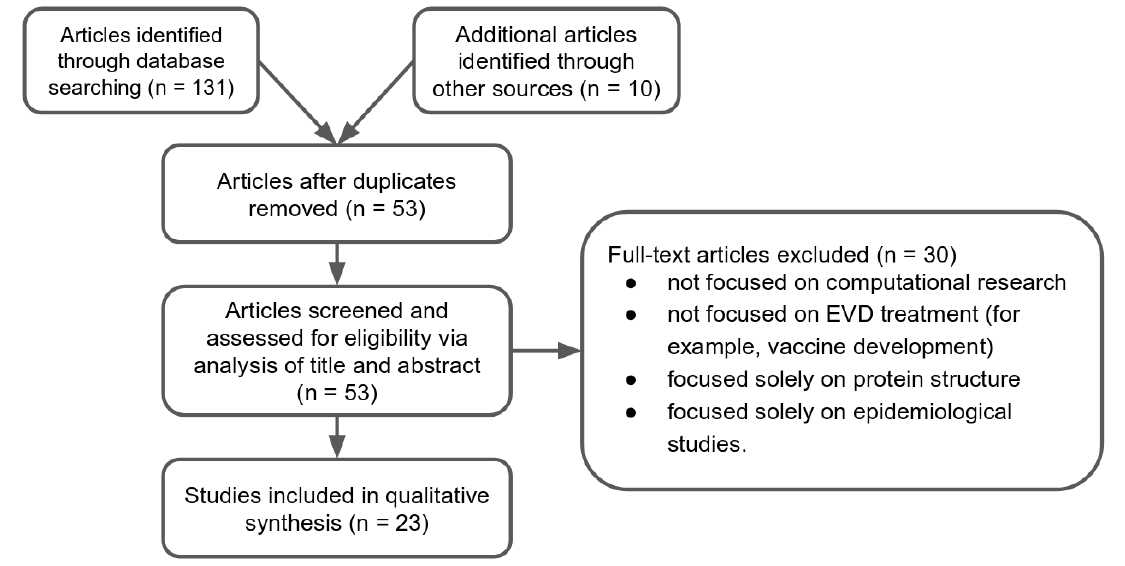
Figure 1. Flow diagram of the study identification process. A total of 141 publications from our initial queries were winnowed down to 23 for further